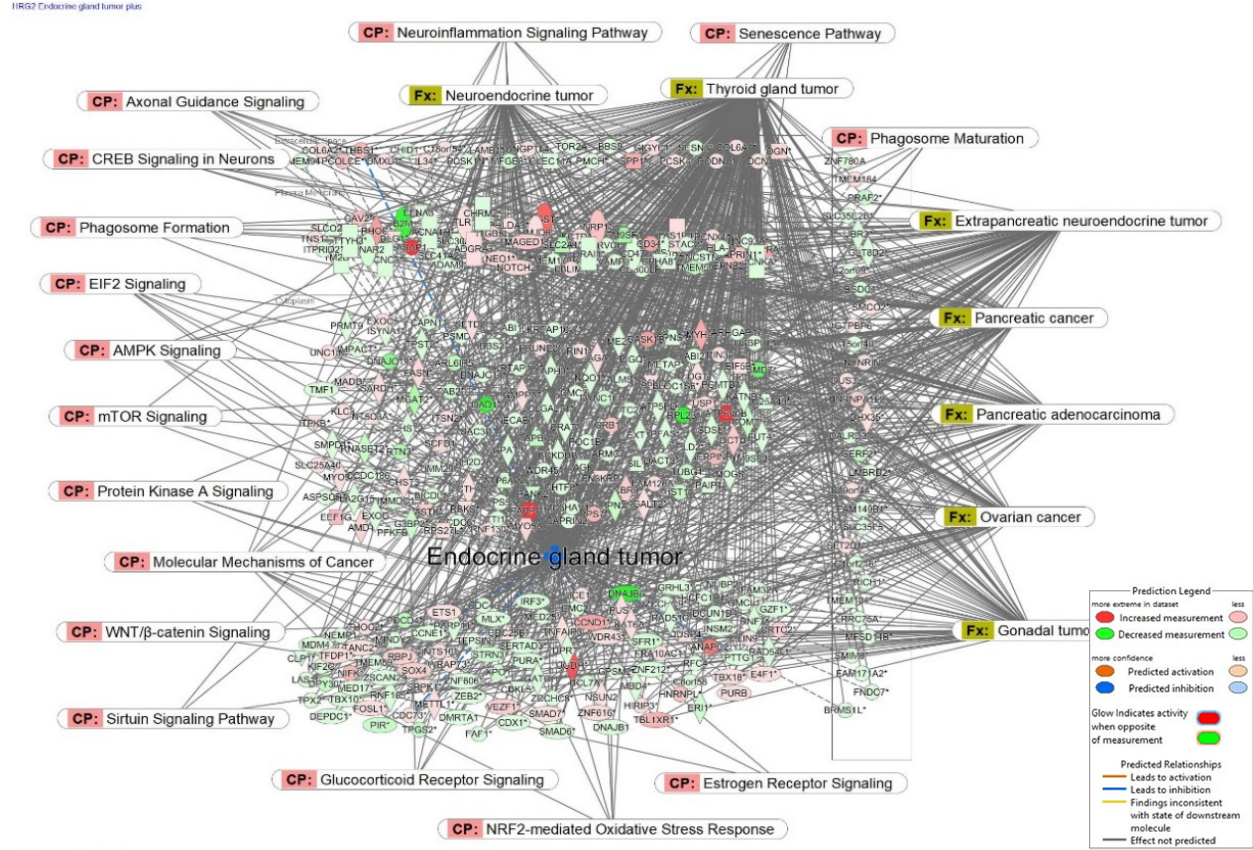
Figure 5. The molecular network shows predicted inhibition of exocrine gland tumor by an extract of red ginseng at a concentration of 1 μ g/mL. Solid red or green color nodes indicate upregulated and downregulated genes, respectively; color intensity indicates the actual log-fold changes—the tags labeled with purple display the canonical pathways related to particular genes of the network. The titles marked with khaki show various types of tumors associated with the molecules in subnetworks. Reprinted from Reference [8]. Table 1. Pharmacological activities of adaptogens. Adapted from [6,9,13,113]. Stimulating and tonic effects on the CNS system